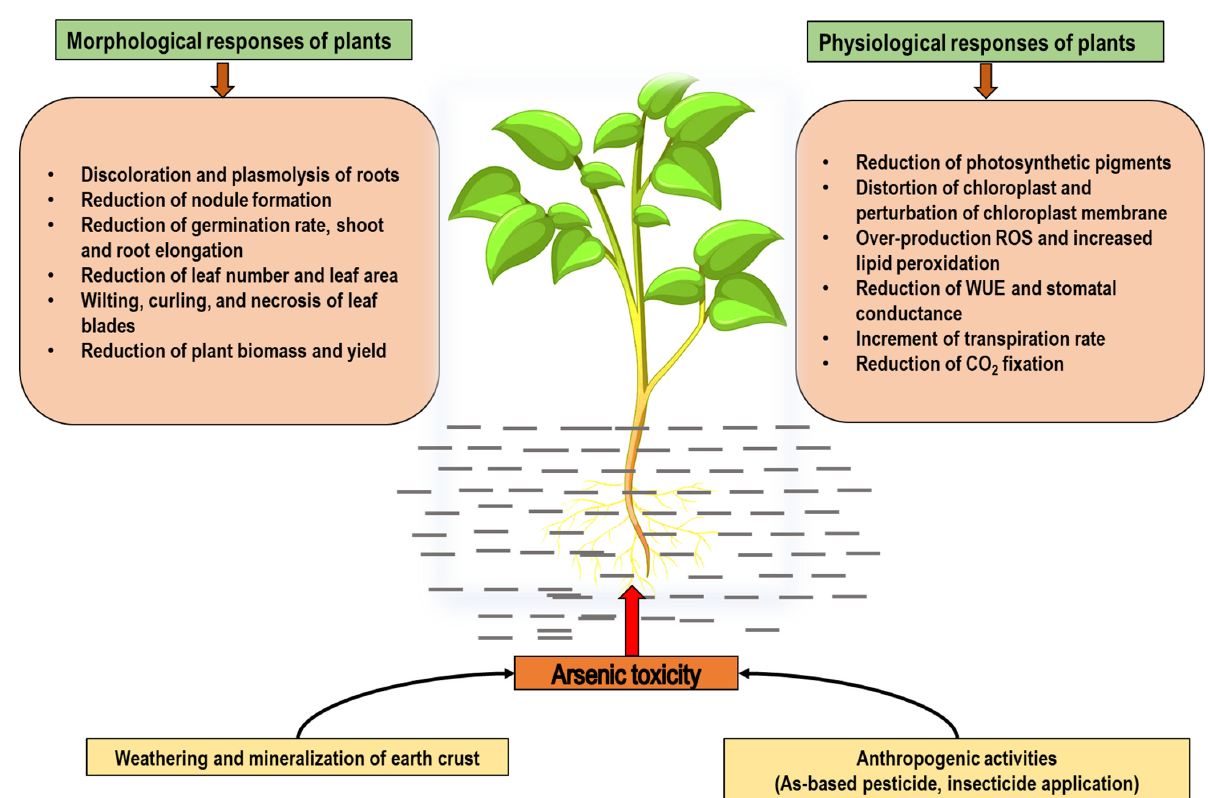
Figure 2. Arsenic-induced morphological and physiological responses of plants.